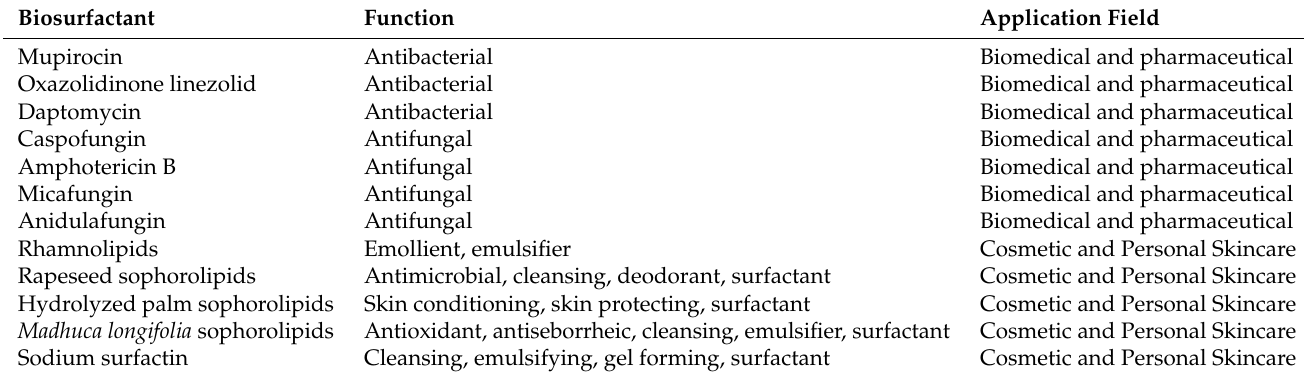
Table 1. BSs and BS-derived compounds that have reached a commercial